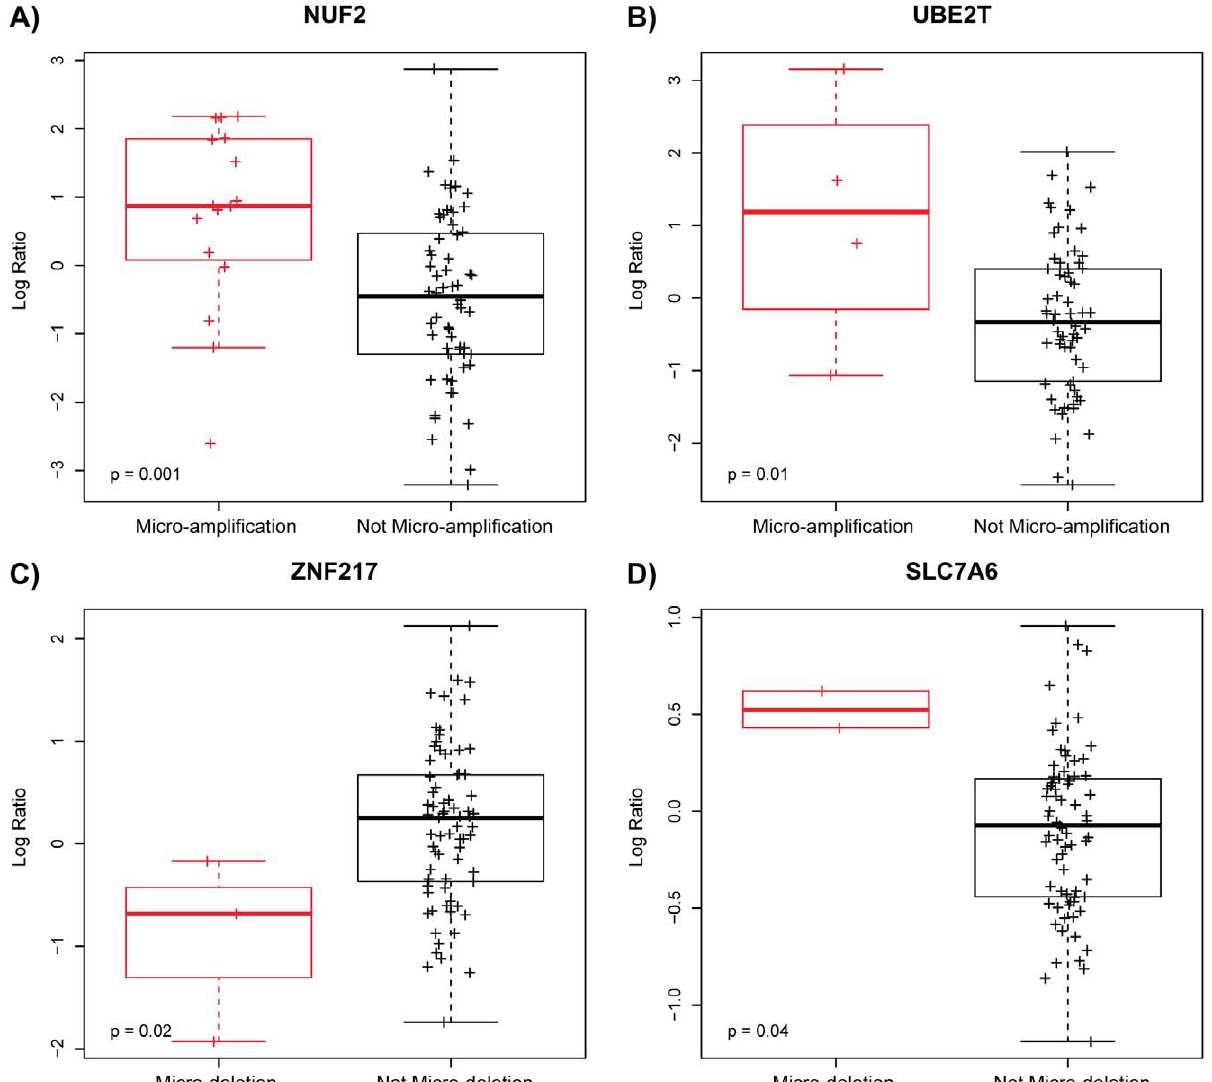
Figure 3. The presence of micro-aberrations can result in differential expression by copy number status. Samples with micro- amplifications in A) NUF2 and B) UBE2T are associated with significantly higher expression of the gene than samples without these aberrations. Samples with micro-deletion in C) ZNF217 are associated with significantly lower expression of the gene than samples without these aberrations. Samples with micro-deletion in D) SLC7A6 are associated with significantly higher expression of the gene than samples without these aberrations.